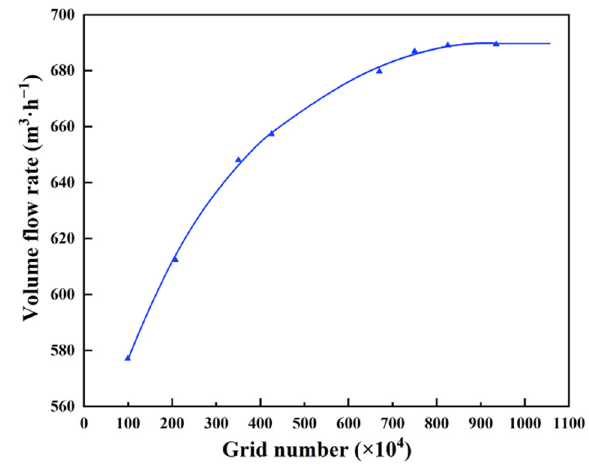
Figure 3. Grid independence test.